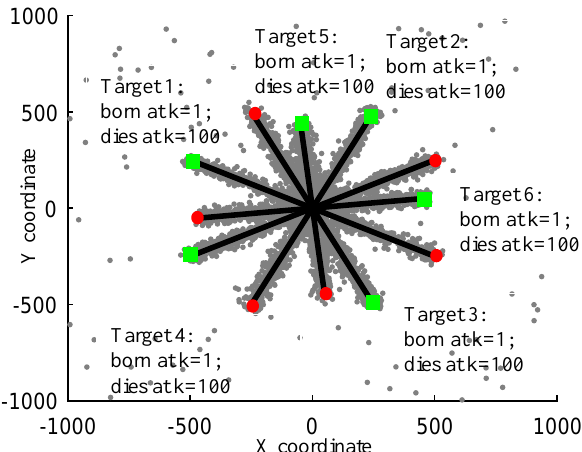
Figure 13. True tracks and measurements with clutter. Green square is the beginning point of the track; red circle is the end point of the track.